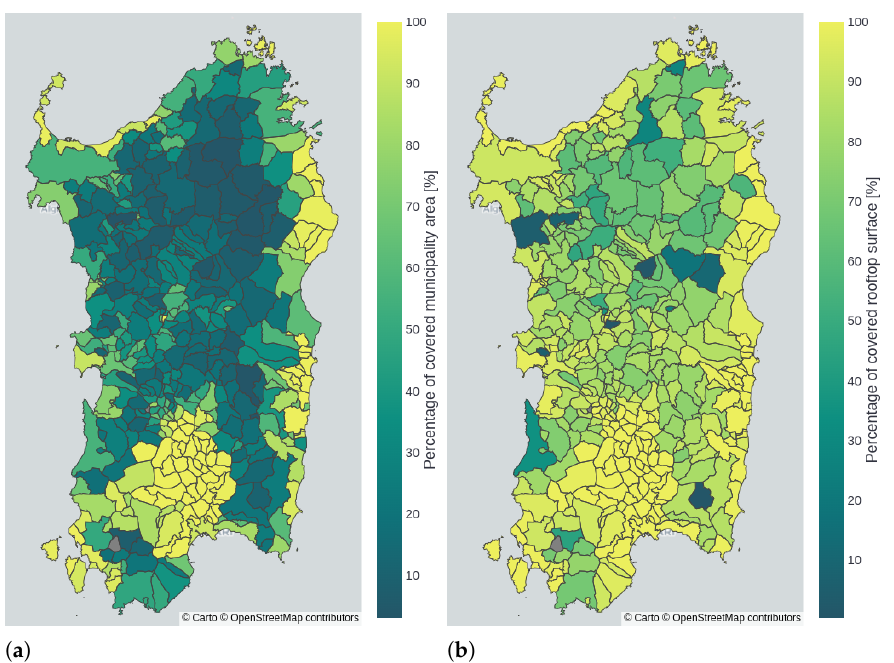
Figure 3. ( a ) Percentage of municipality area and ( b ) percentage of rooftop surface covered by the DSM.